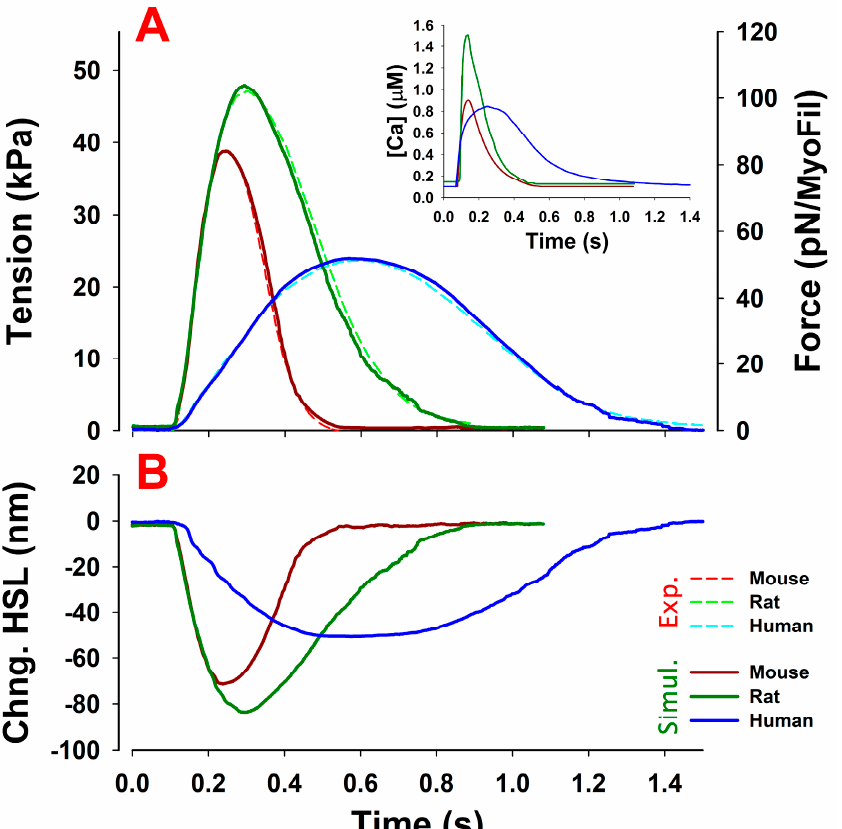
Figure 2. MUSICO predictions of twitch contractions in mouse, rat and human fixed-length trabeculae ( A ). The predicted tensions (thick solid lines) showed excellent agreement with those observed in mice, rat and human trabeculae (Chung et al. [34]) ( thin dashed lines ). The fits were achieved with a six-state crossbridge cycle that includes a parked state (PS) with calcium-dependent k PS and trabeculae series elasticity (SE). The crossbridge cycle state transition rates were for a completely α -cardiac myosin isoform in mice and a predominantly β -isoform in human simulations. In rats, the α - and β -isoform homodimers were randomly distributed, helically arranged myosin head pairs along a thick filament, containing an average of 75% α and 25% β . Following the experiments of Chung et al. [34], the simulations were done on fixed-length trabeculae at a relaxed sarcomere length of 2.2 µm and at 25 °C. The calcium transients (inset) were taken from rat right ventricle (RV) trabeculae at 25 °C (Janssen et al. [35]). The mouse calcium transient was derived from Ferrantini et al. [36] and the human calcium transients were taken from Ferrantini et al. [37]. The common model parameters are shown in Table 1 and parameters specific to mouse, rat and human trabeculae are shown in Table 2. MUSICO simulations also predicted a change in the half-sarcomere length, denoted as “Chng. HSL” in ( B ). The changes in the sarcomere length were not experimentally recorded in mice, rats or humans, but the predicted displacements from the rat simulations were similar to the observations of Caremani et al. [28] in rat fixed-length